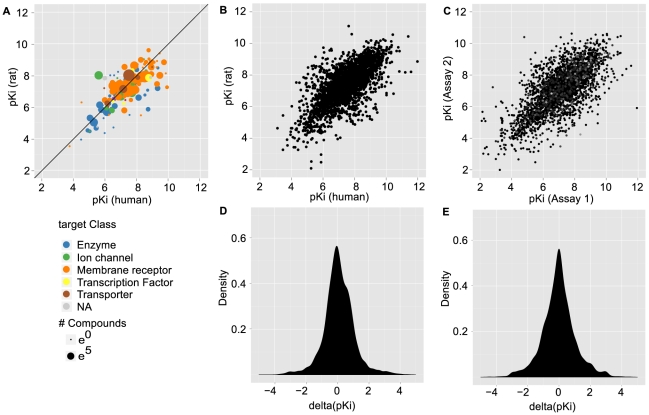
Differences in small molecule binding for human to rat orthologs.(a) Summary scatter plot. Positions along axes report the median binding affinity of all compounds against the human target (x-axis) and its ortholog in rat. Points are scaled according to the number of different compounds tested against a pair of orthologs. (b) Scatter plot of individual compound binding affinities for the human targets (x-axis) and their orthologs in rat (y-axis). (c) Scatter plot of the affinities observed when comparing results from different assays of the same compound and target (1500 human targets and 1500 rat targets). (d) Distribution of differences in binding affinity between the human target and its ortholog in rat. Positive values indicate higher affinity for the human target and vice versa. (e) Distribution of the differences observed when comparing binding affinities for the same compound and target in different assays.